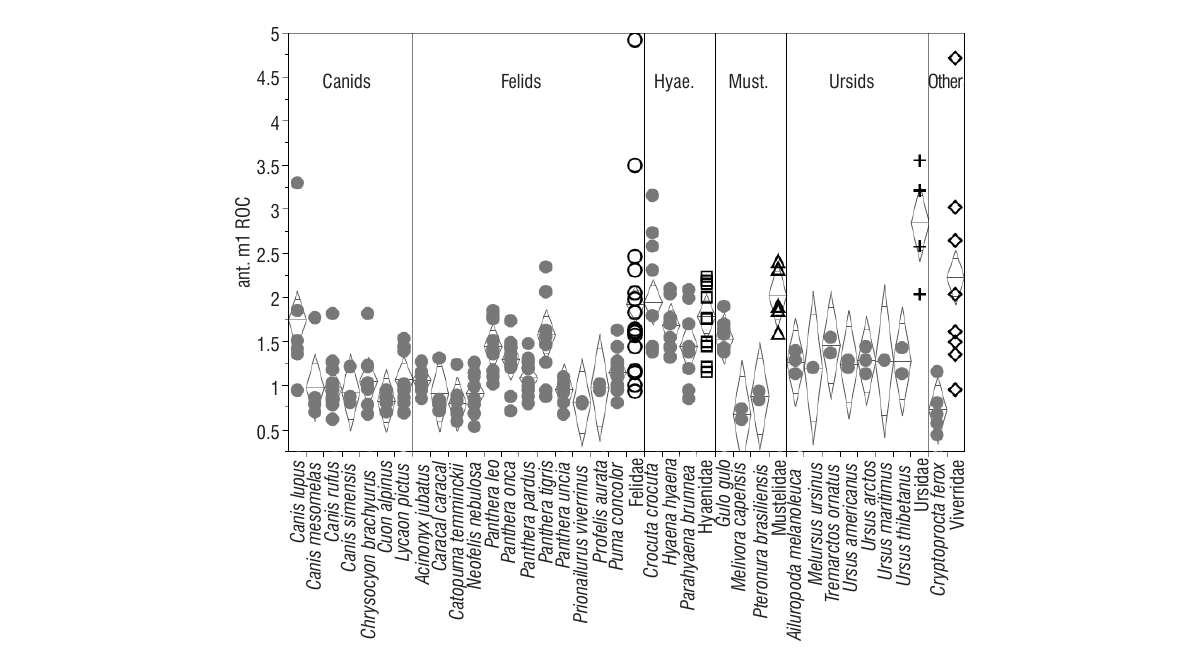
Extant taxa are represented by solid grey circles, Langebaanweg (LBW) felids by open circles, LBW hyaenids by open squares, LBW mustelids by open triangles, LBW ursids ( Agriotherium ) by ‘+’ signs, and LBW viverrids by open diamonds. Each dotted diamond represents the mean and 95% confidence interval vertical span; the horizontal lines are the mean and ‘overlap marks’ that indicate statistical separation. Figure 6: Radii-of-curvature (ROC) score of the anterior (paraconid) carnassial (m1) cusp by